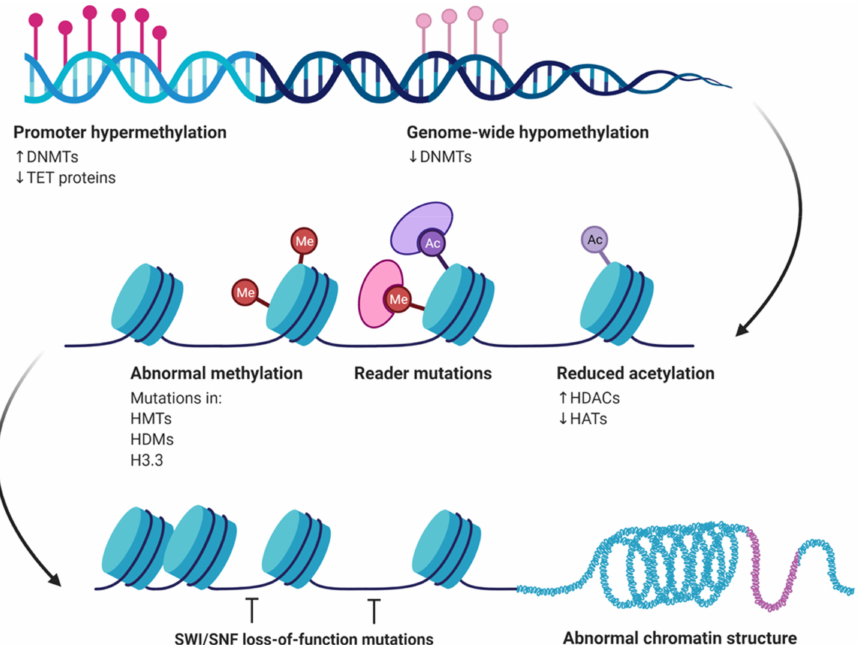
Figure 1. Post-translational epigenetic modifications, including methylation and acetylation, interact with gene expression either through chromatin structure alteration or histone modifiers recruitment.